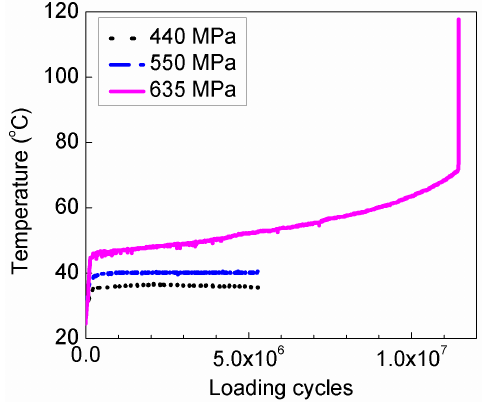
Figure 9. Variation of the surface temperature of the smallest section of HU-specimens with loading cycles during ultrasonic fatigue test.